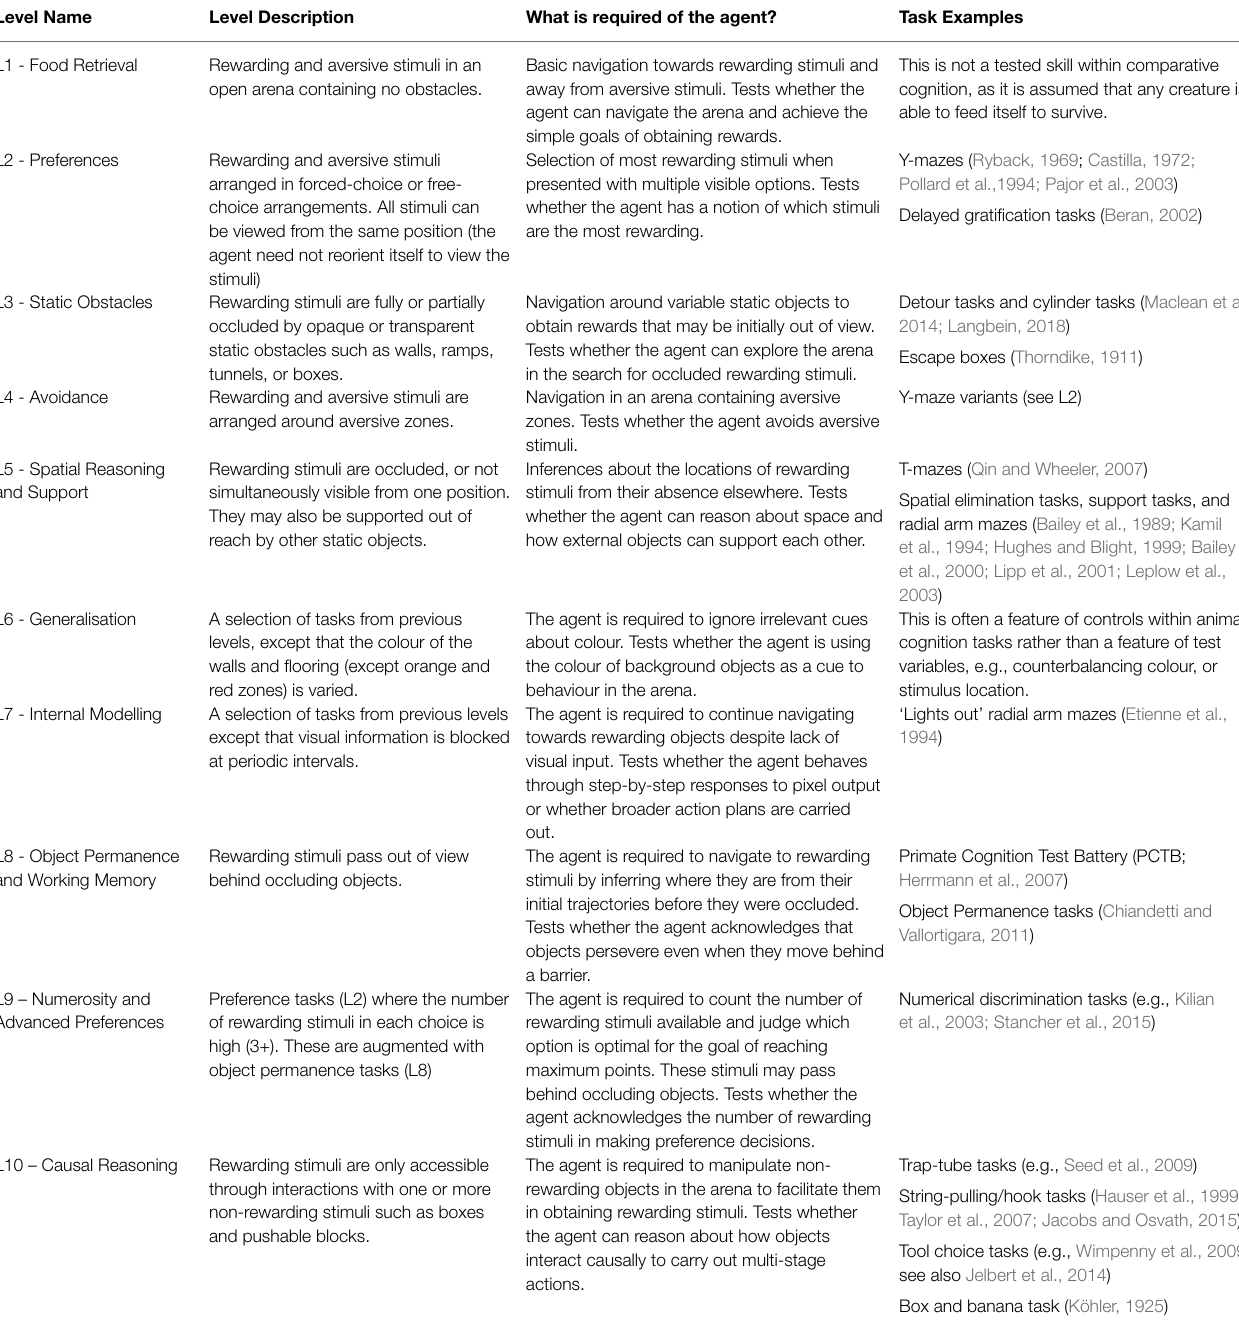
TABLE 1 | Tasks grouped into 10 levels of increasing